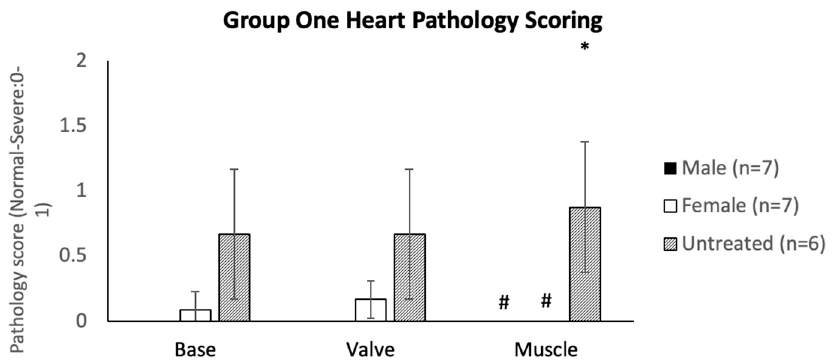
Figure 9. Heart pathology scoring of Group One (mice treated with the TBG promoter; 5 × 10 13 GC/kg body weight) ranged from normal (0) to severe (1). Error bars display standard deviation. ** indicates a two-tailed t -test p -value of <0.05 compared to the opposite sex. # indicates a two-tailed t - test p -value of <0.05 compared to the untreated